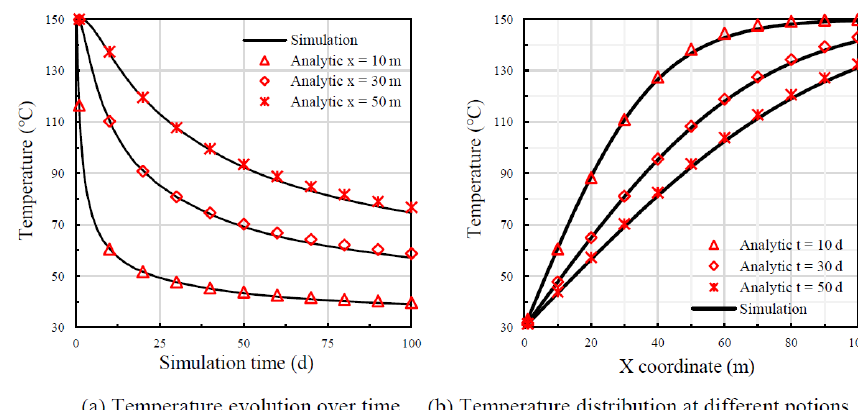
Figure 3. Comparison between analytical solution and numerical simulation.